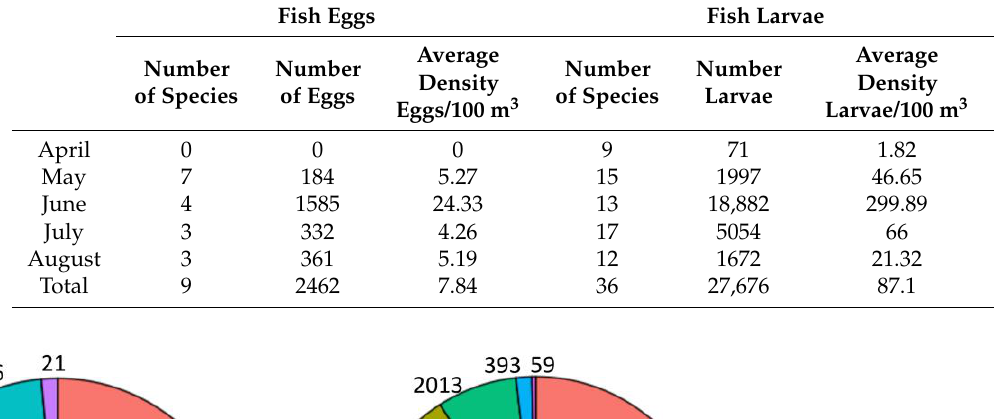
Table 1. Species number, quantity and average density of fish eggs and larvae in Oujiang River Estuary from April to August 2015.